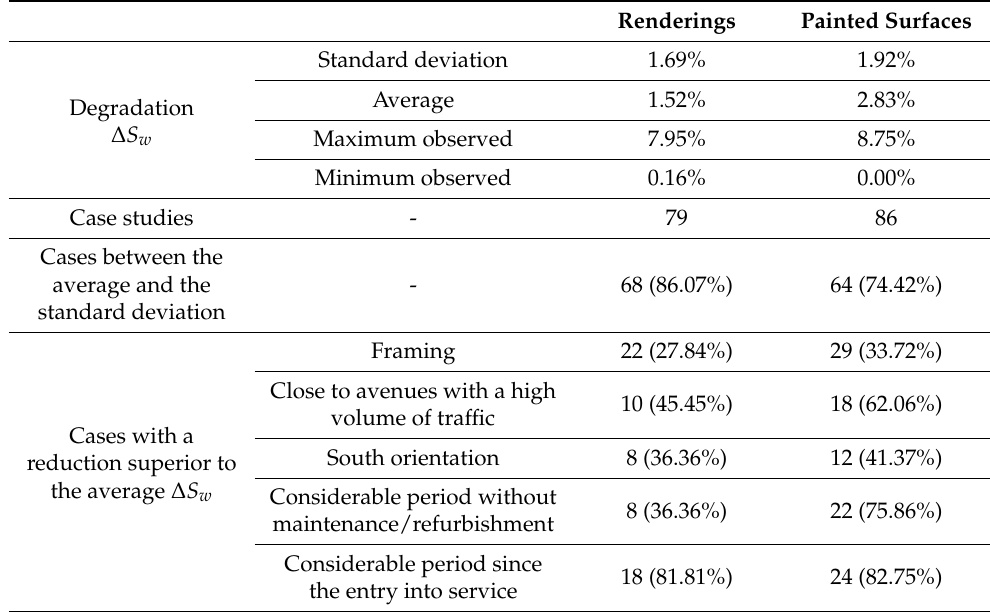
Table 2. Descriptive analysis of the impact of cleaning actions on the severity of degradation